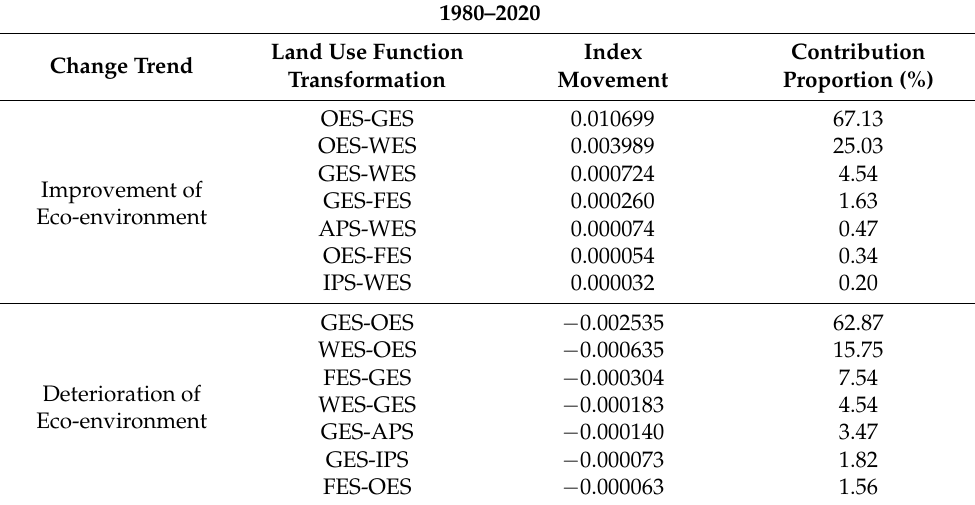
Table 6. Major land use transformations influencing ecological environment quality and contribution rates.